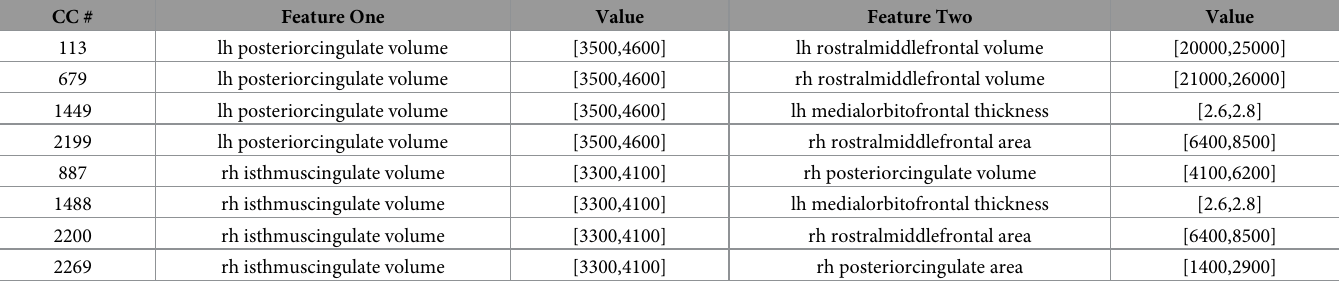
Table 3. Second-order CC model features and range of